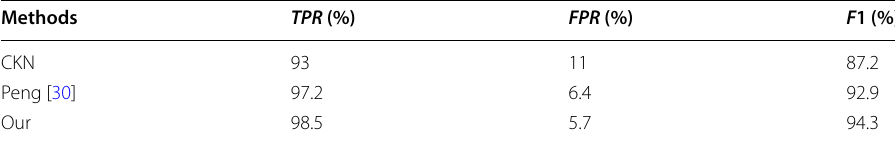
Table 9 Comparison of different methods